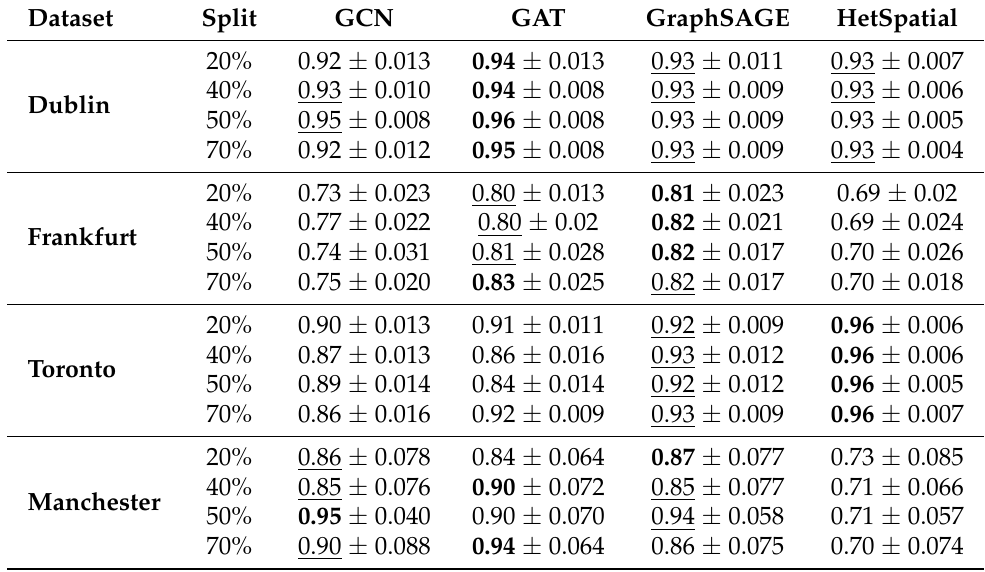
Table 6. Table showing the micro F1-score results for building type inference. The values in bold and underlined represent the best and second best performing approaches for each city/split, respectively.